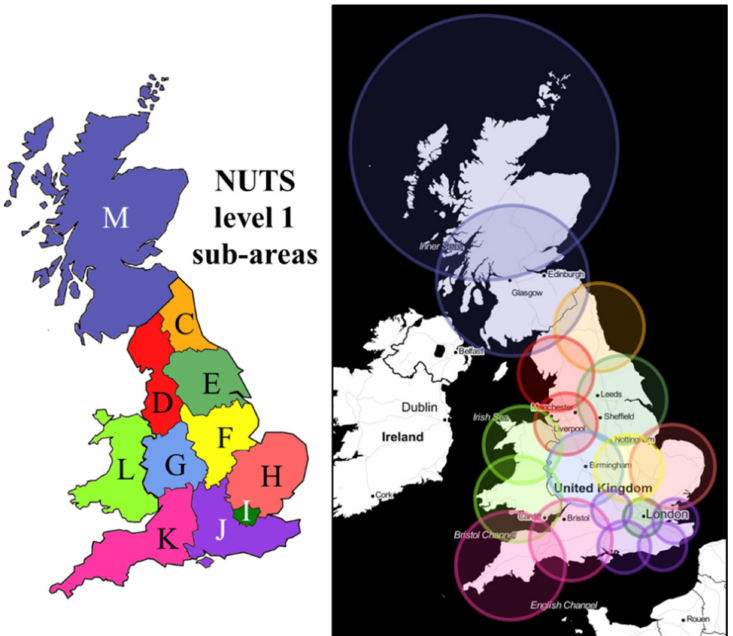
Figure 1. Left : Great Britain (GB) NUTS sub-areas; right : the original “theory of circles” applied to GB. Note. C = North East; D = North West; E = Yorkshire and the Humber; F = East Midlands; G = West Midlands; H = East of England; I = London; J = South East; K = South West; L = Wales; M =